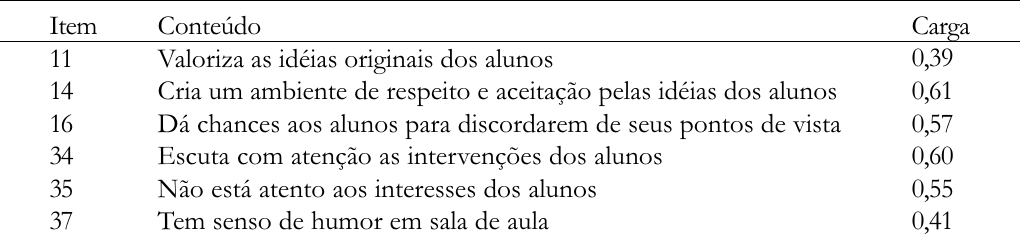
Fator 2 (cid:150) Clima para Expressªo de